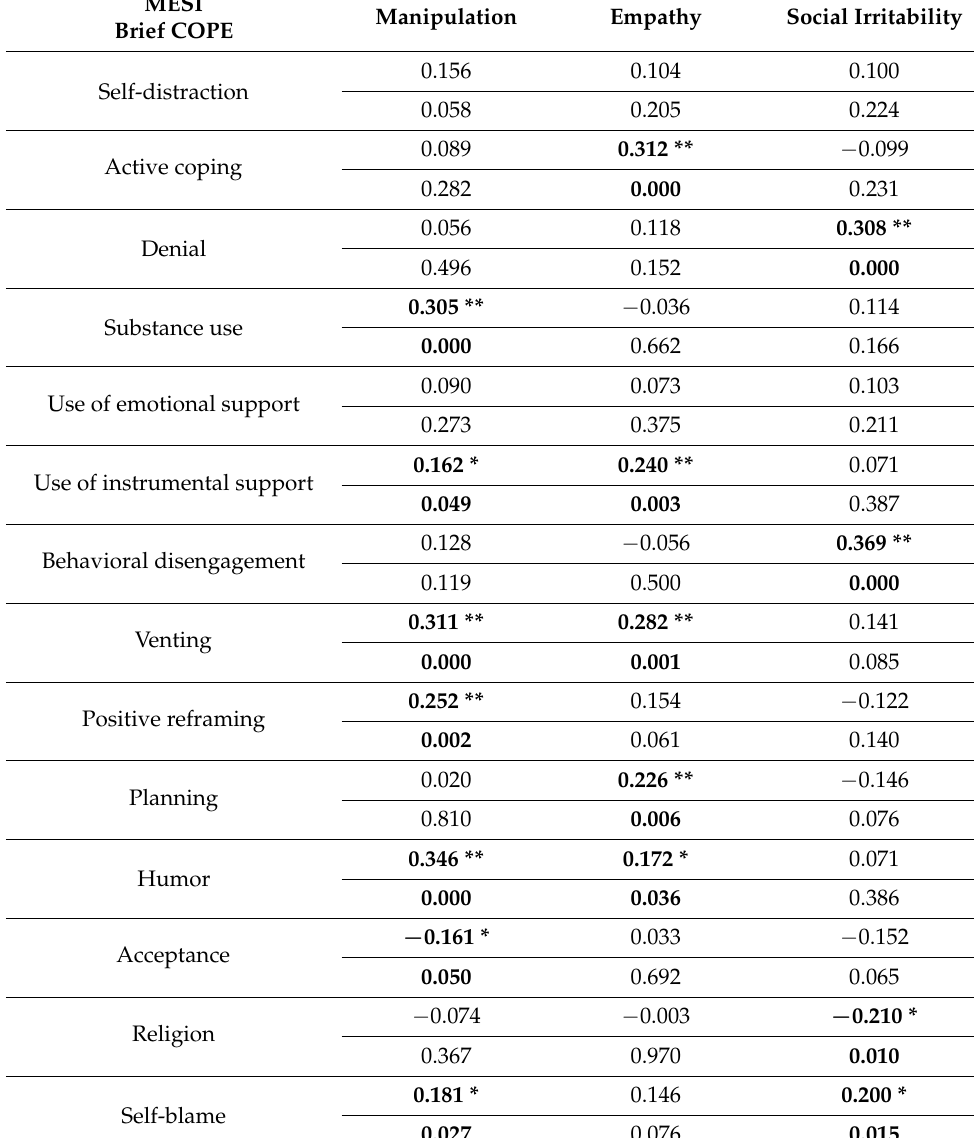
Table 1. Correlations between social intelligence factors (MESI) and coping strategies (Brief COPE).